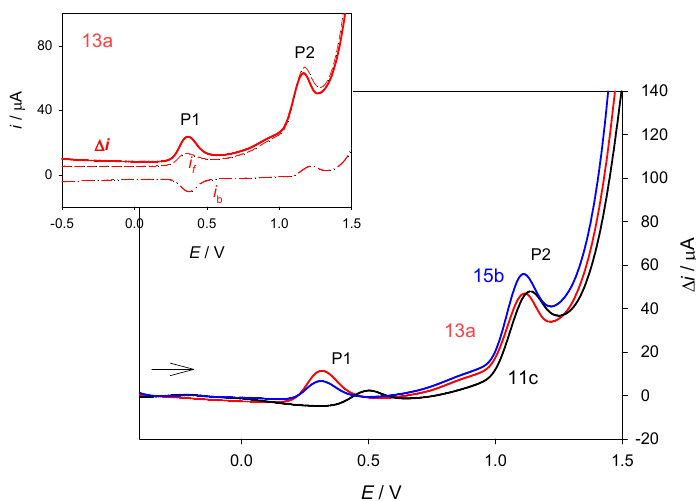
Figure 2. Square-wave voltammograms for the oxidation of 11c , 13a and 15b in 0.5 mol / L NaClO 4 at pH 9. Conditions: c ( 13a ) = 0.1 mmol / L, c ( 11c ) = c ( 15b ) = 0.05 mmol / L, E sw = 50 mV, E s = 2 mV, f = 100 Hz. Inset: The net SWV response ( ∆ i ) and its forward ( i f ) and backward ( i b ) current components, for the oxidation of 13a . Arrow indicates the scan direction.